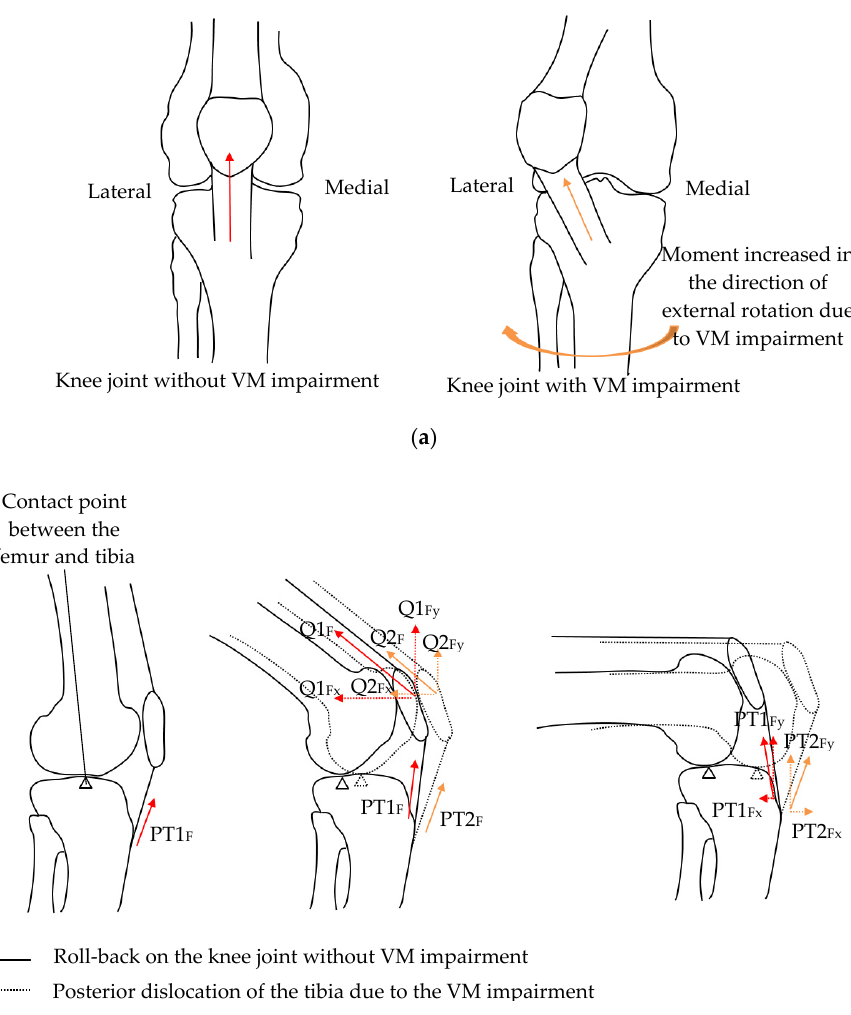
Figure 5. Changes in quadriceps and patellar tendon vectors of the load (Q1F: quadriceps force without VM impairment; Q2F: quadriceps force with VM impairment; PT1F: patellar tendon force without VM impairment; PT2F: patellar tendon force with VM impairment) due to VM impairment: ( a ) increased external moment due to VM impairment on the frontal plane; ( b ) posterior dislocation of the tibia due to VM impairment on the sagittal plane.